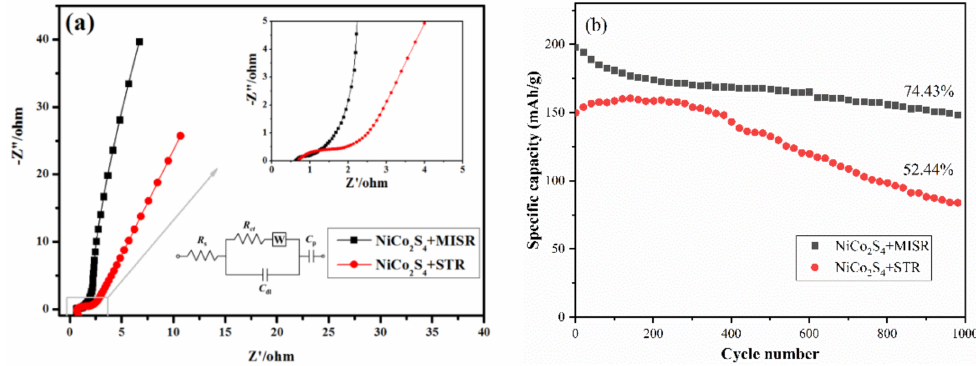
Figure 4. ( a ) EIS Nyquist plots and ( b ) cycling performance of the MISR-prepared and the STR- prepared NiCo 2 S 4